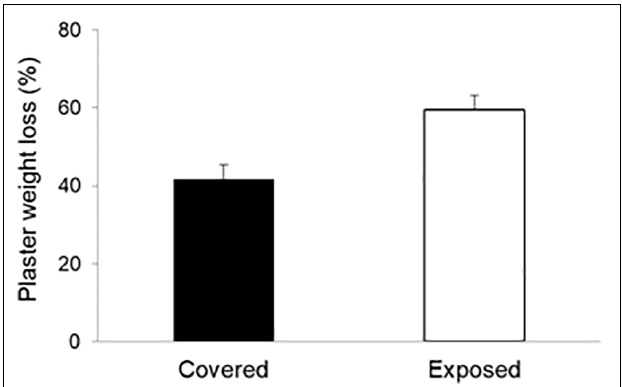
FIGURE 5 | Flow/abrasion rates at the surfaces of mussel-covered and mussel-removal (exposed) benches based on the weight losses of plaster discs (5 cm diameter, 1.5 cm height). Discs attached to the mussel-covered benched had their sides shielded by the surrounding mussels. The vertical lines above the bars indicate 1 SD. Differences among treatments were significant ( p < 0.001).